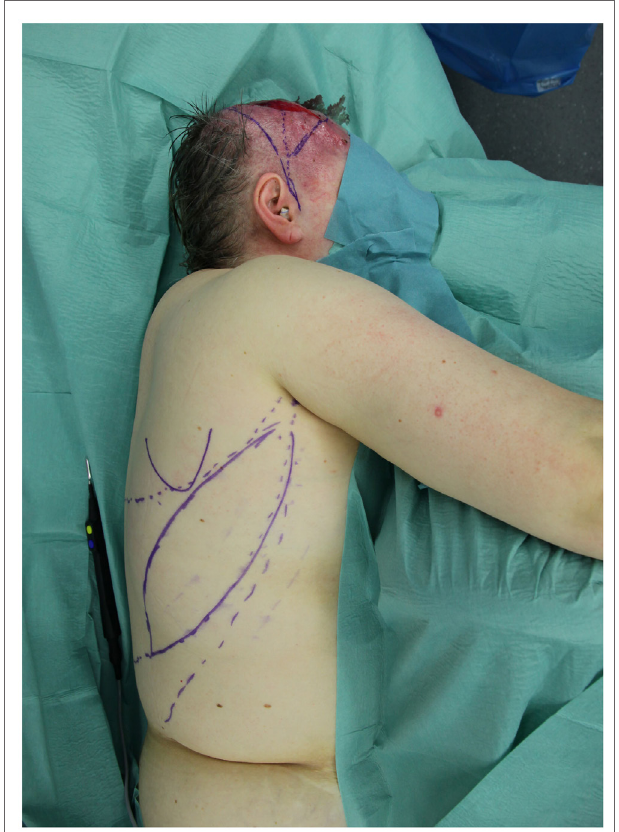
FiGURe 1 | intraoperative view of a patient with an oncological defect of the scalp . The latissimus skin paddle as well as the anatomical landmarks are